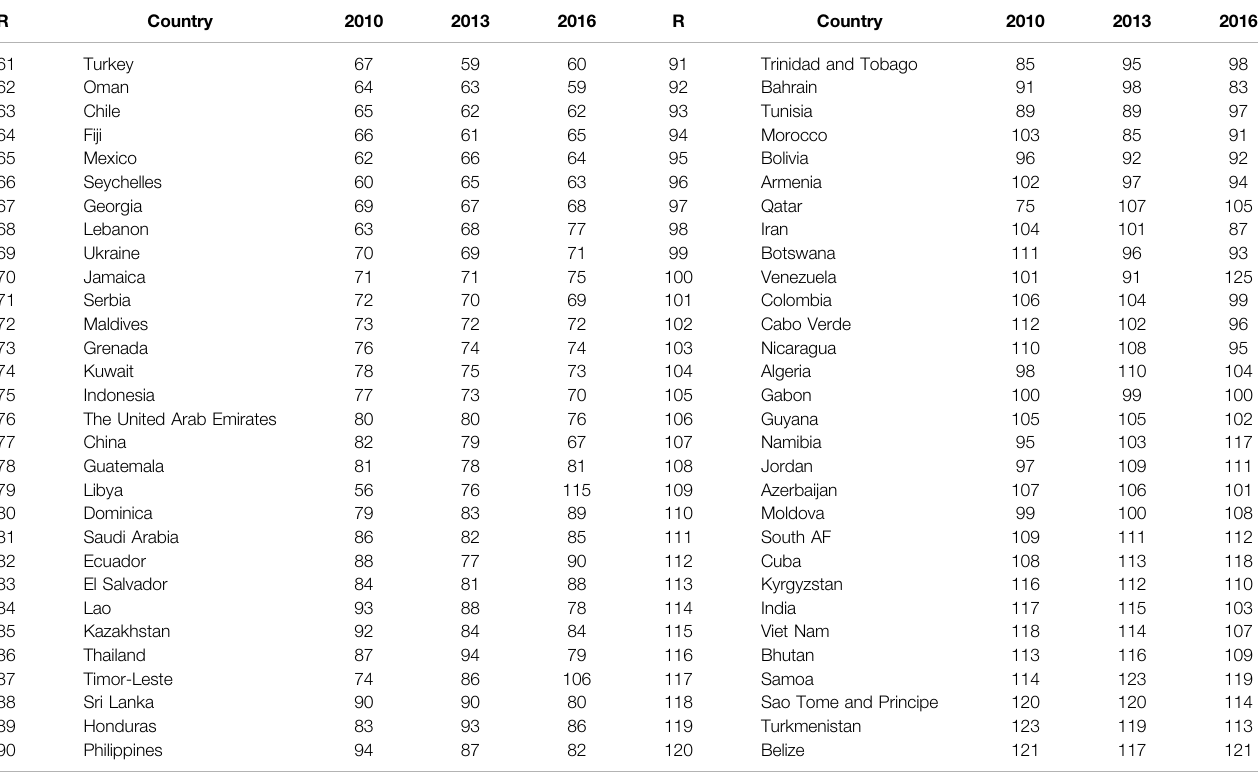
TABLE 5 | Rankings of medium-NSDI